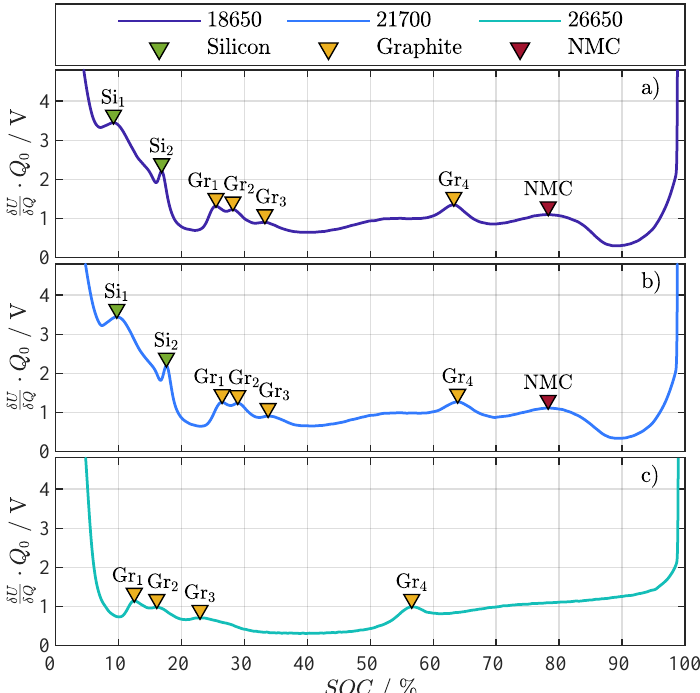
Figure A1. Differential voltage analysis with representative peak markers for silicon (Si x ), graphite (Gr x ), and NMC for the three investigated cell formats: 18650 with NMC NMC Si/Gr ( b ), and 26650 with LMO |